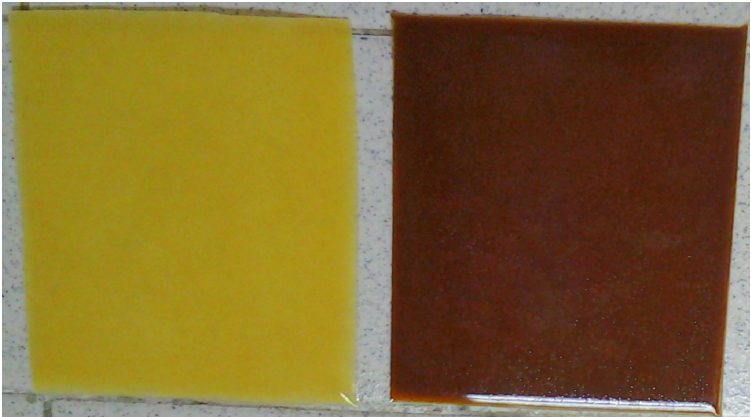
Figure 1. Image of bleached ( left ) and unbleached ( right ) kenaf fiber/PLA composite.